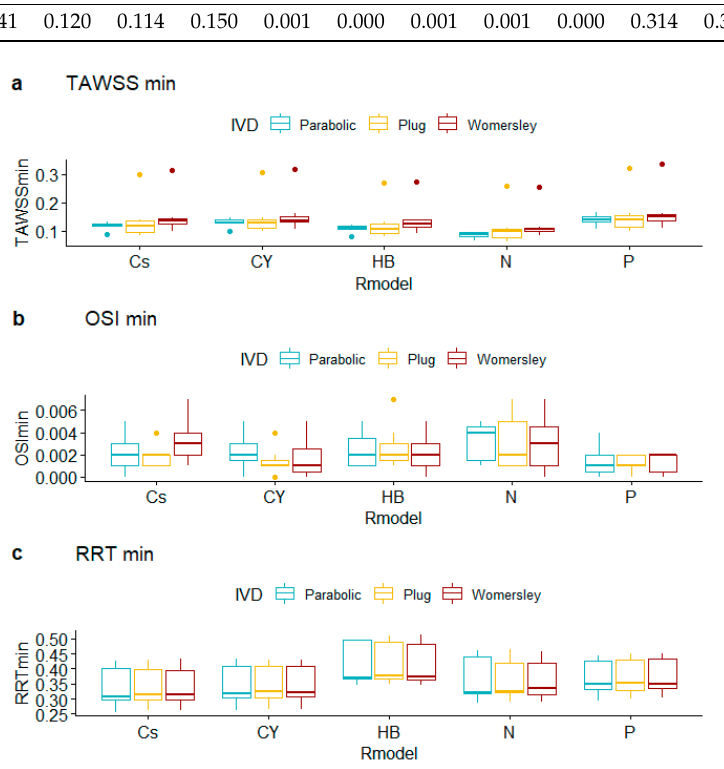
Figure 9. Boxplots of observed minima of hemodynamic variables for alternative rheological models and inlet velocity distributions.